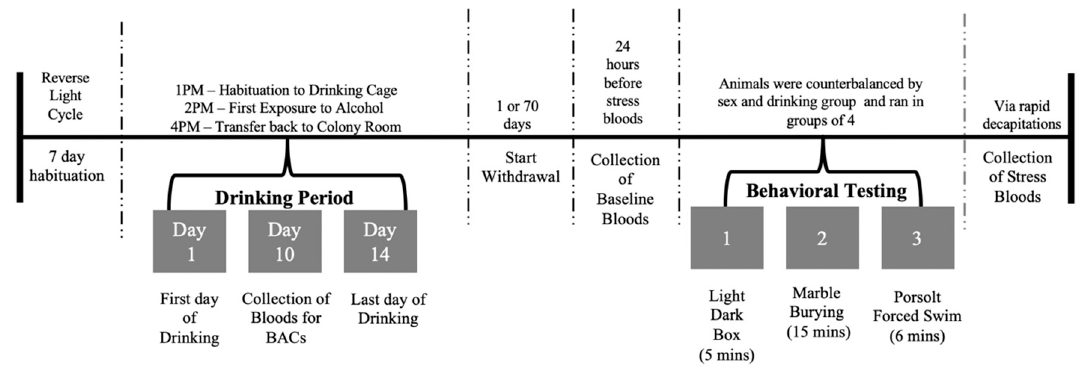
Figure 1. Summary of the procedural time-line for this study.